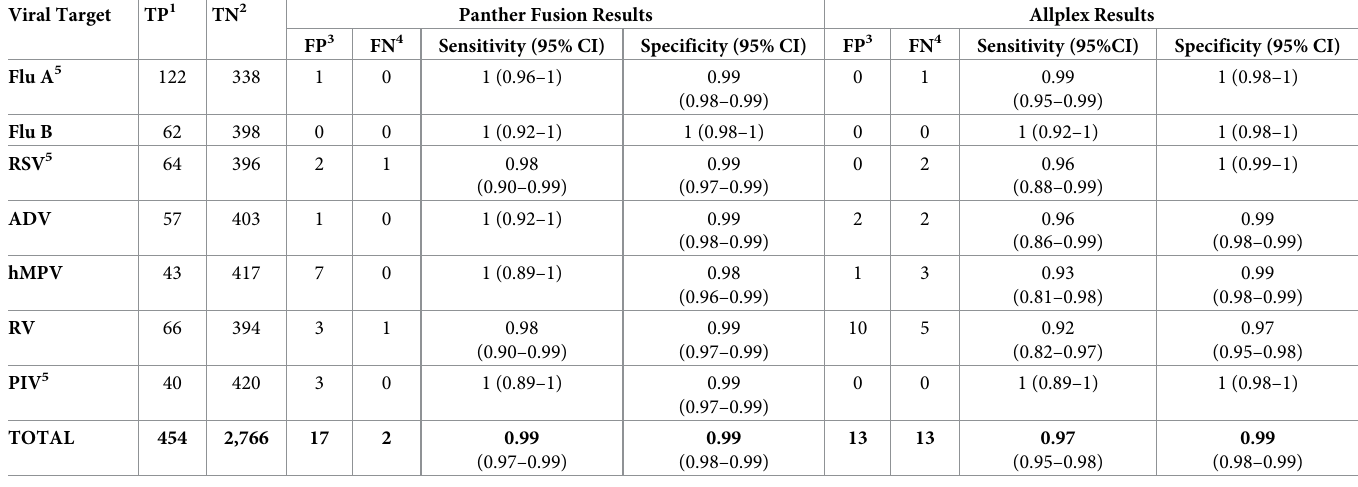
Table 3. Retrospective comparison of Panther Fusion and Allplex for detection of viruses in stored clinical